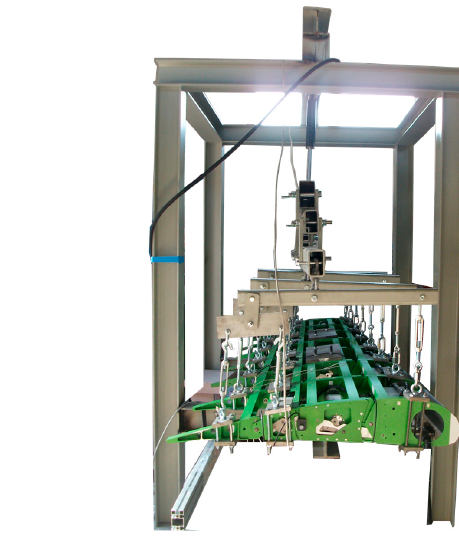
Aerospace 2018 , 5 , x FOR PEER REVIEW Figure 18. Whiffletree and rig for static test. Figure 18. Whiffletree and rig for static test.